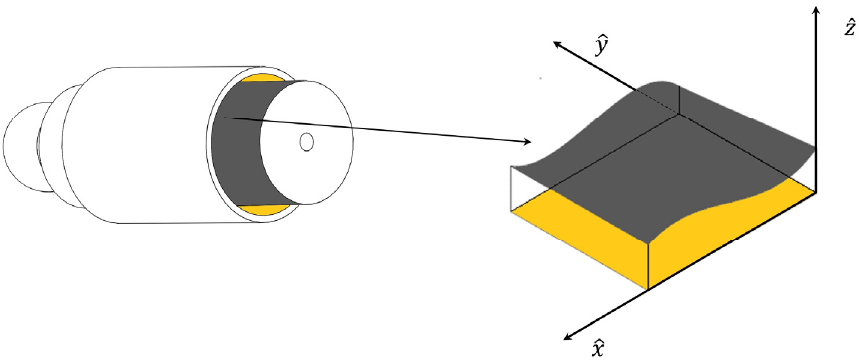
one denotes the bushing surface.